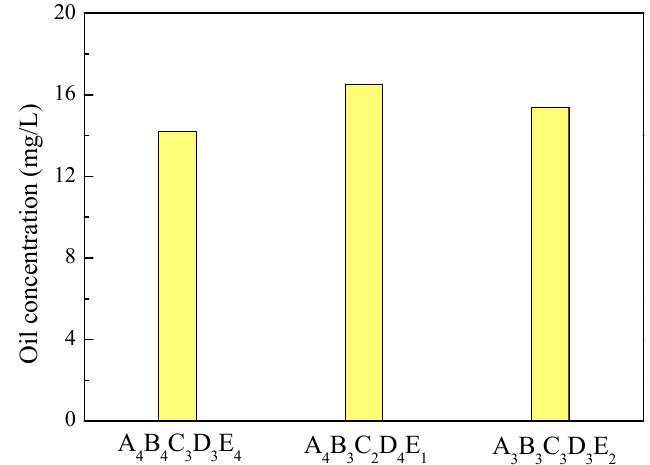
Figure 11. Oil concentrations achieved by different treatment schemes.